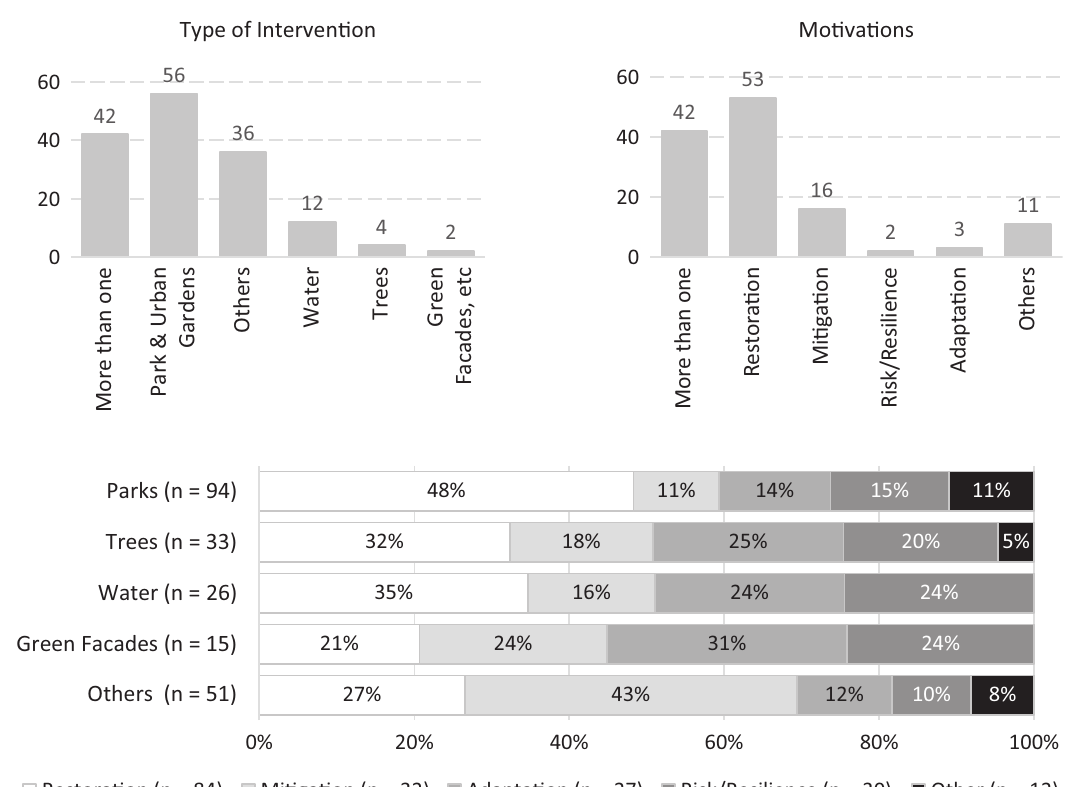
Figure 3. Typology and motivation of